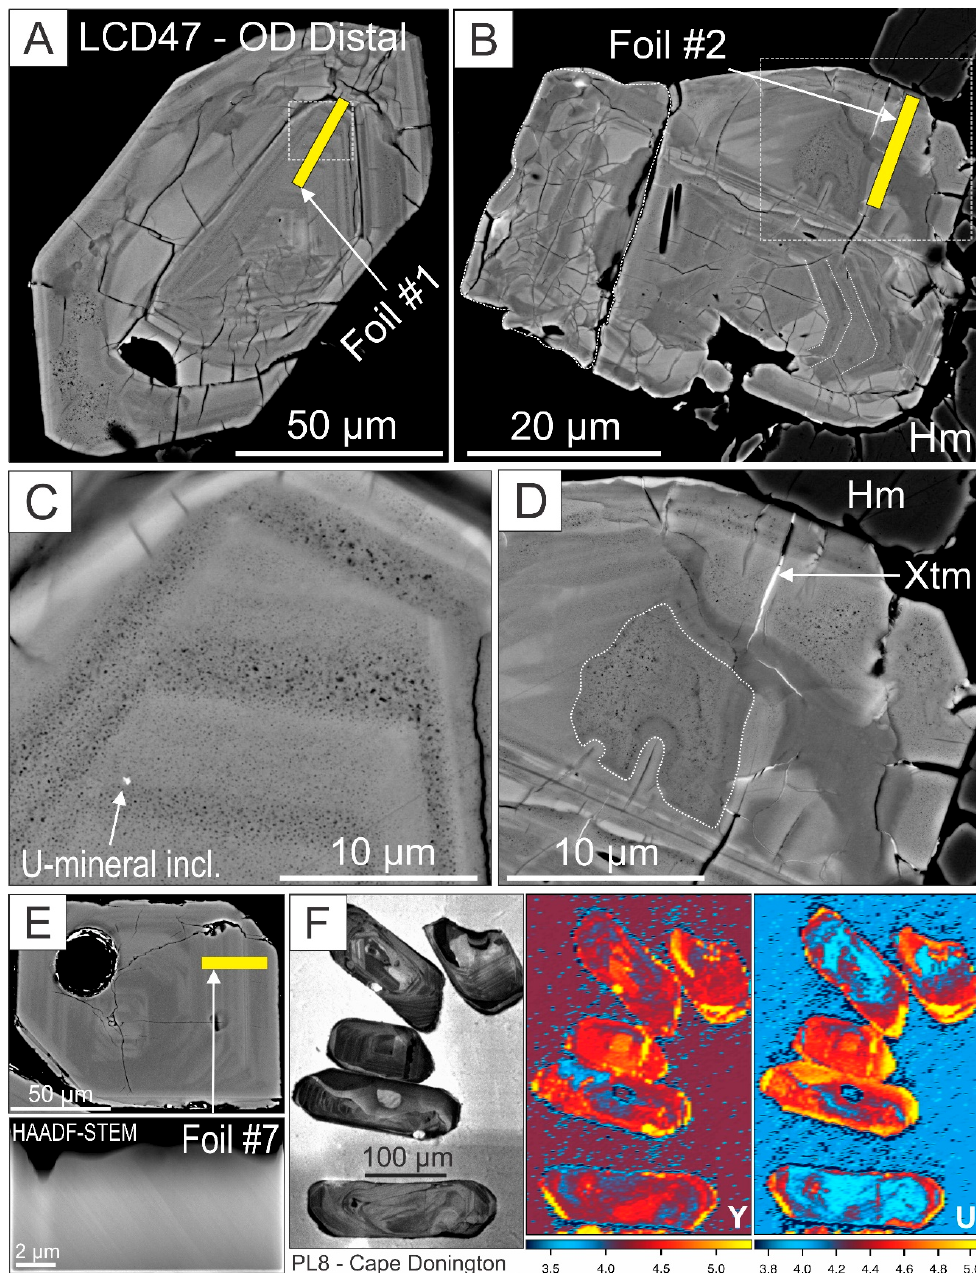
Figure 2. BSE images of grains #1 ( A and C ) and #2 ( B and D ) from OD distal zircon (sample LCD47). Note the mottled dark areas were either bands within crystal oscillatory zoning ( C ) or scalloped domains superimposed onto crystal zoning ( D ). ( E ) BSE (top) and HAADF STEM image (bottom) showing crystal oscillatory zoning for Cape Donington zircon (PL8). ( F ) Cathodoluminescence image (left) and LA-ICP-MS element maps (right) showing oscillatory zoned patterns for Y and U in coarser zircon grains from PL8. Scale in 10 n counts per second (extended maps are given in Supplementary Materials C, Figure S2).